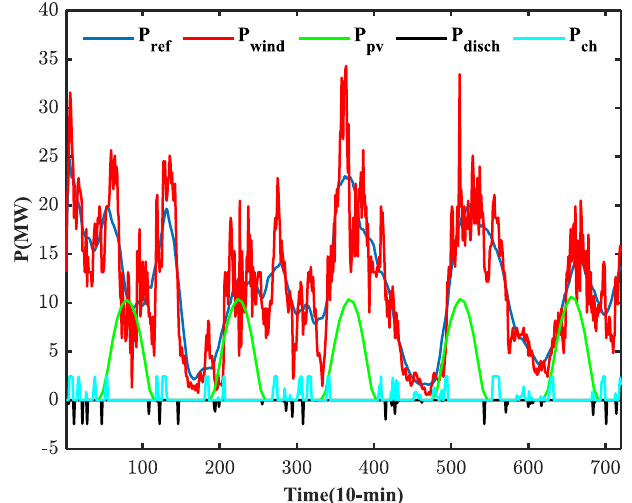
Figure 16. Sample of 5-day HWSPS output power